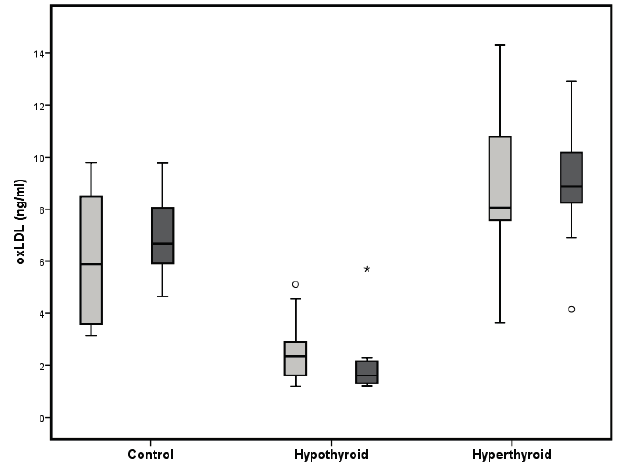
Figure 1. Box and Whisker Blot of oxidized LDL. Grey bars indicate normal diet and black bars indicate high fat diet. * p < 0.05 compared to appropriate diet control group; º p < 0.05 compared to normal diet control